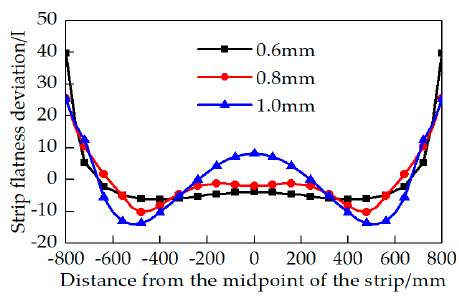
Figure 17. The effect of different thicknesses on the flatness calculation deviation . Figure 17. The e ff ect of di ff erent thicknesses on the flatness calculation